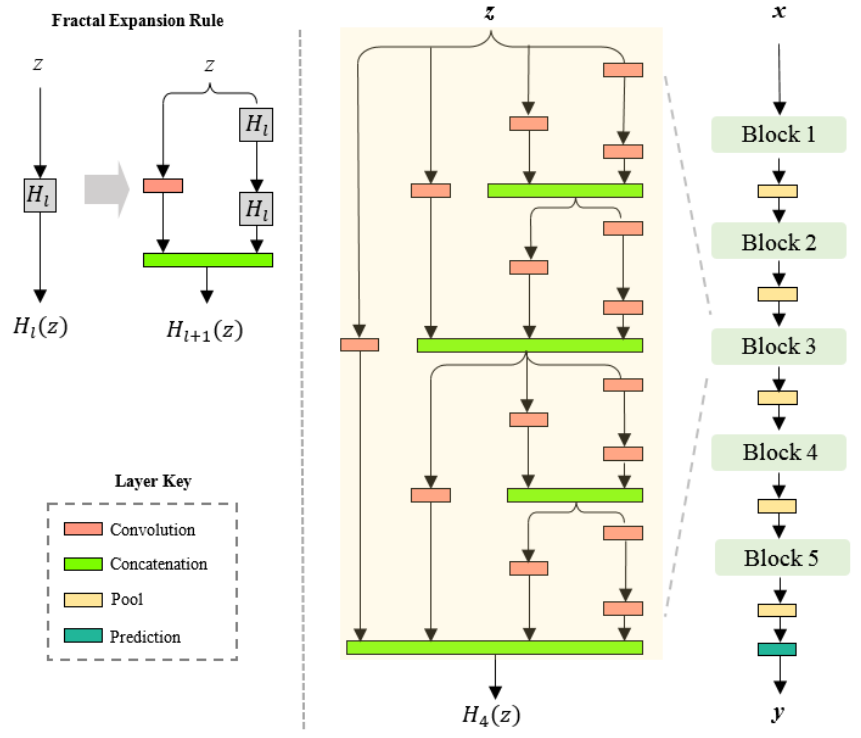
Figure 3. Dense network unit. Fractal structures have statistical or similar self-similar forms.